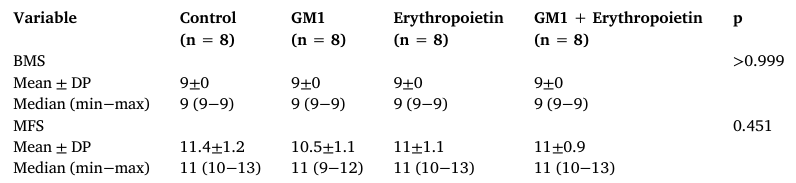
Table 6 Multiple comparisons of immunohistochemical parameters among